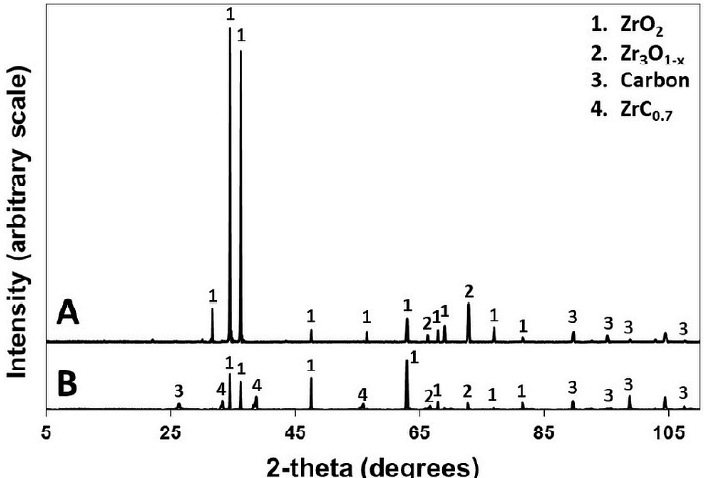
Fig. 4 . SEM micrographs of the zirconium coating on graphite etched with 80 ml H HNO for 2 seconds: (A) fully dense Zr deposit, and (B) the coating-graphite interface. A hairline delamination 3 and crack at the interface can also be seen at high magnification.